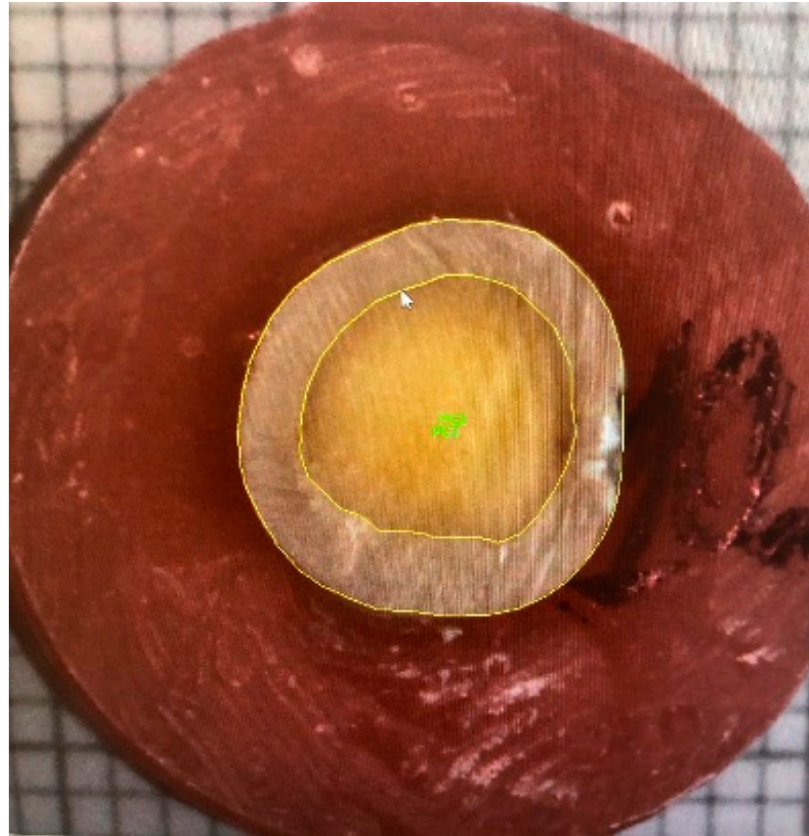
Figure 3. Measuring enamel and dentin areas. The area of enamel and dentine including the border line is marked respectively.